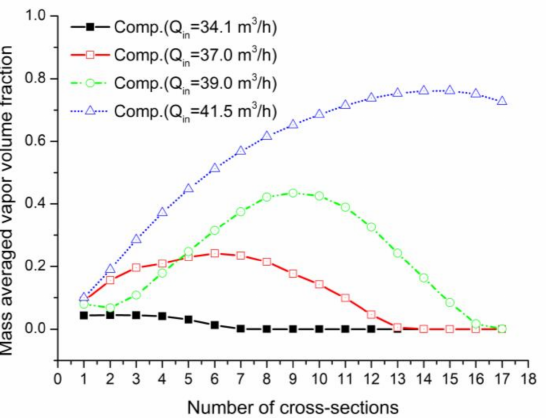
Figure 15. The mass-averaged vapor volume fraction in the axial cross-sections downstream of the eighth stage orifice depending on the operating flow